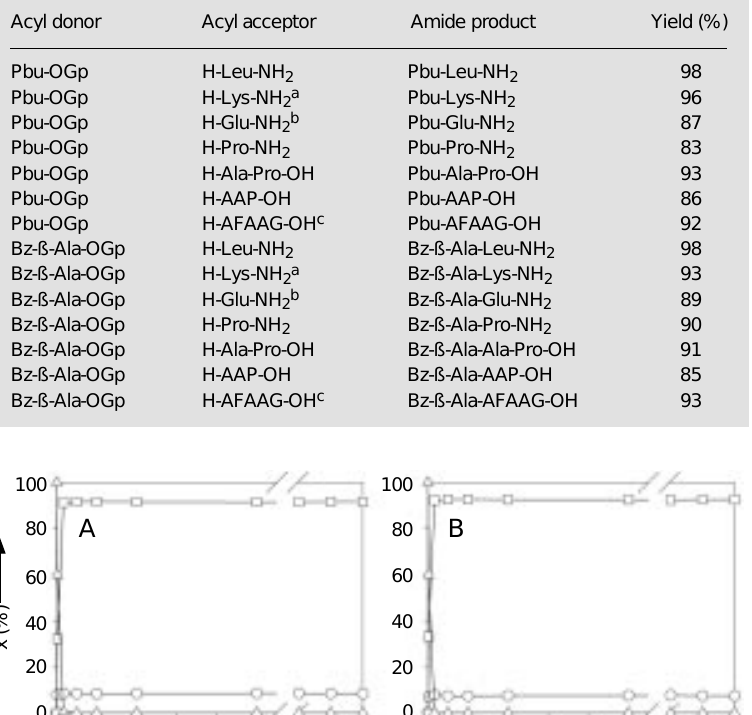
6 - Clostripain-catalyzed coupling of Bz-ß-Ala-OGp and Pbu-OGp with selected amino acid amides and peptides (46). Conditions: 0.2 M HEPES-buffer, pH 8.0, 0.1 M NaCl, 10 mM CaCl 2 , 5% DMF, 25 o C; [acyl donor]: 2 mM, [acyl acceptor]: 25 mM. a [H-Lys-NH 2 ]: 15 mM. b [H-Glu-NH 2 ]: